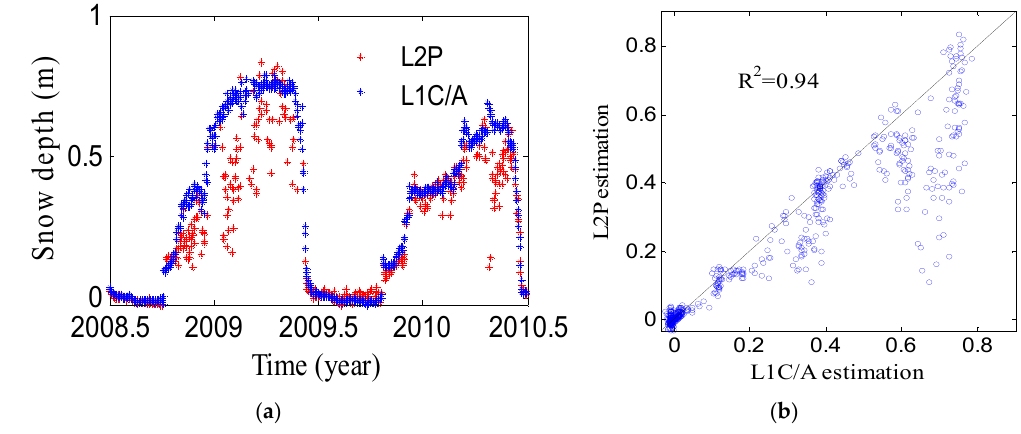
Figure 12. Comparison of L1C/A and L2P results at SG27. ( a ) Snow depth estimation from L1C/A and L2P; ( b ) Correlation between L1C/A and L2P.